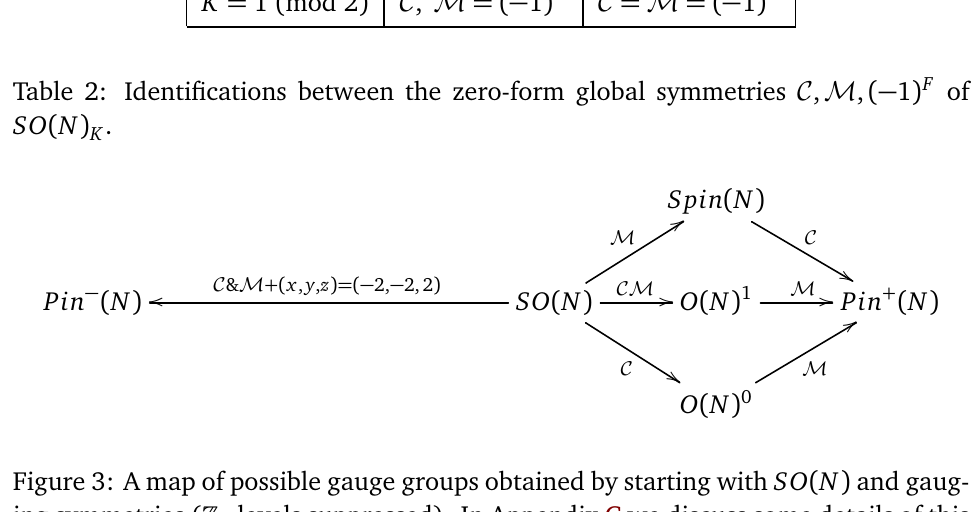
Figure 3: A map of possible gauge groups obtained by starting with SO ( N ) and gaug- ing symmetries ( (cid:90) levels suppressed). In Appendix C we discuss some details of this 2